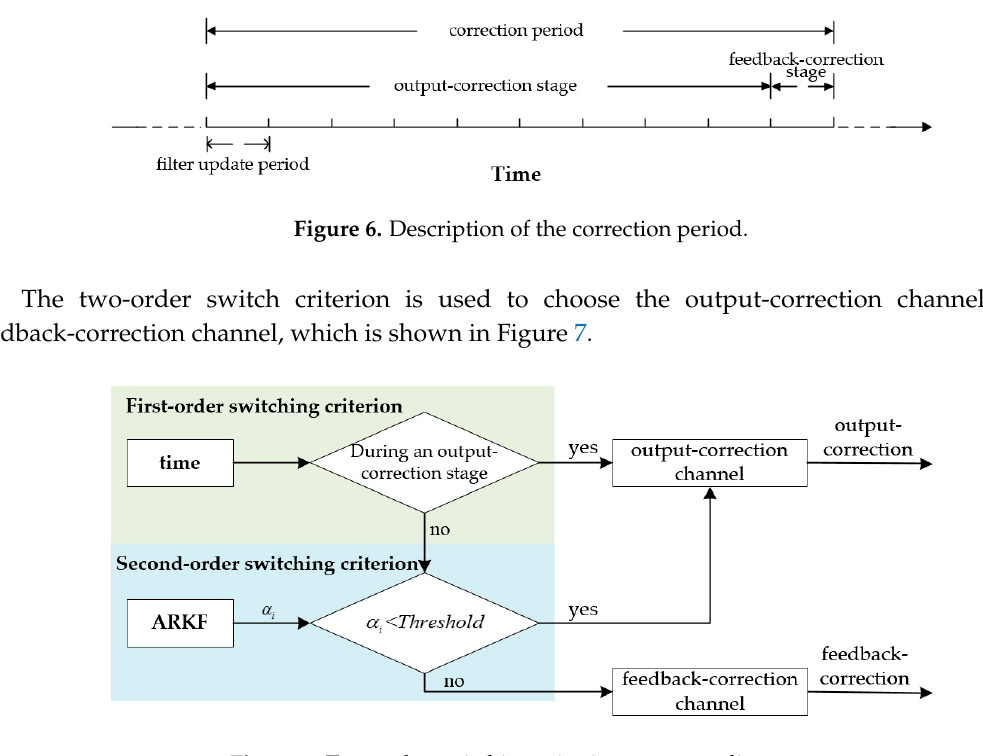
Figure 7. Two-order switching criterion structure diagram.